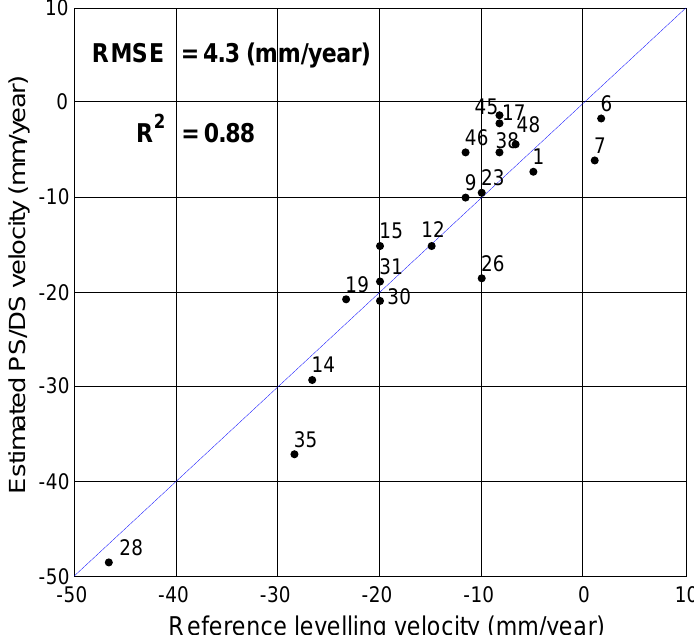
Figure 7. Diagram showing the comparison velocity between the reference leveling and the estimated PS/DS result. The locations of the leveling measurement are shown in Figure 2 and in Table A1. The RMSE is 4.3 mm/year and the correlation is R 2 =